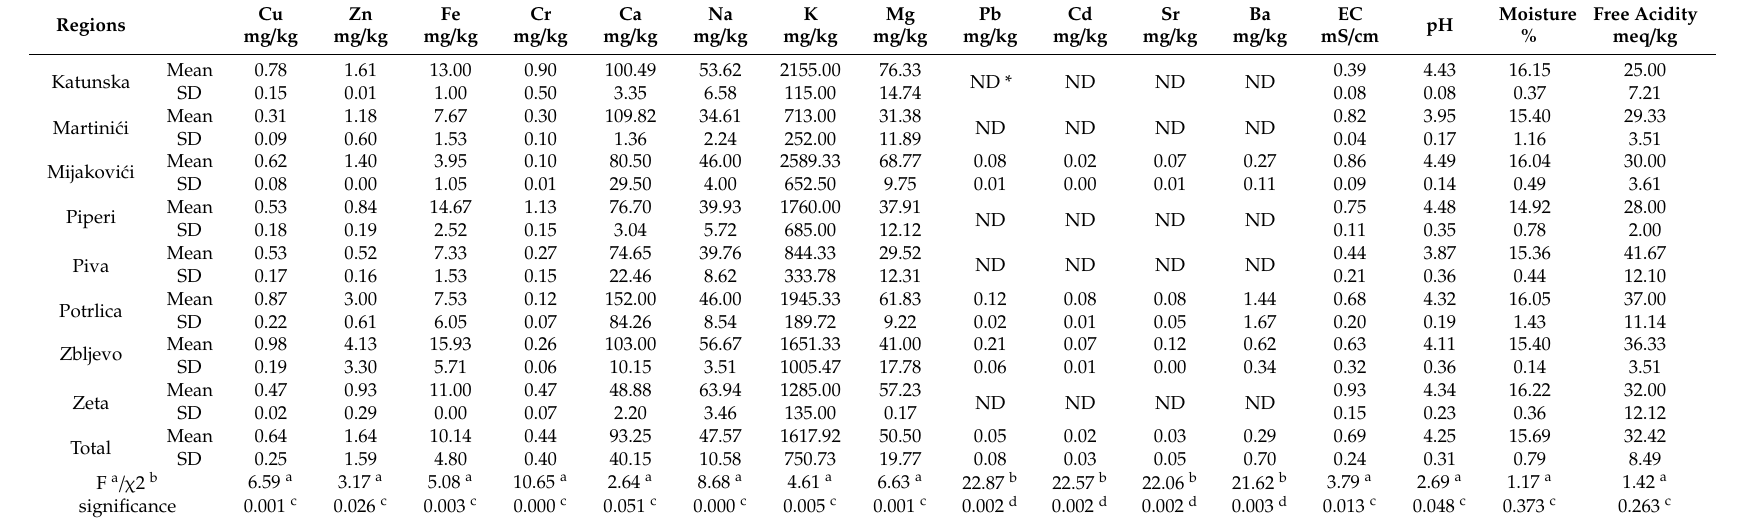
Table 1. Mineral content and physicochemical parameters of honey samples from studied micro-regions of